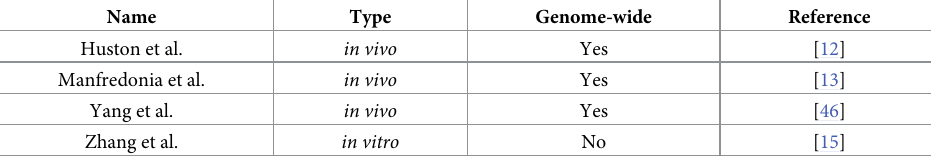
Table 2. List of SARS-CoV-2 SHAPE reactivity datasets used in this work with their referred name, type and